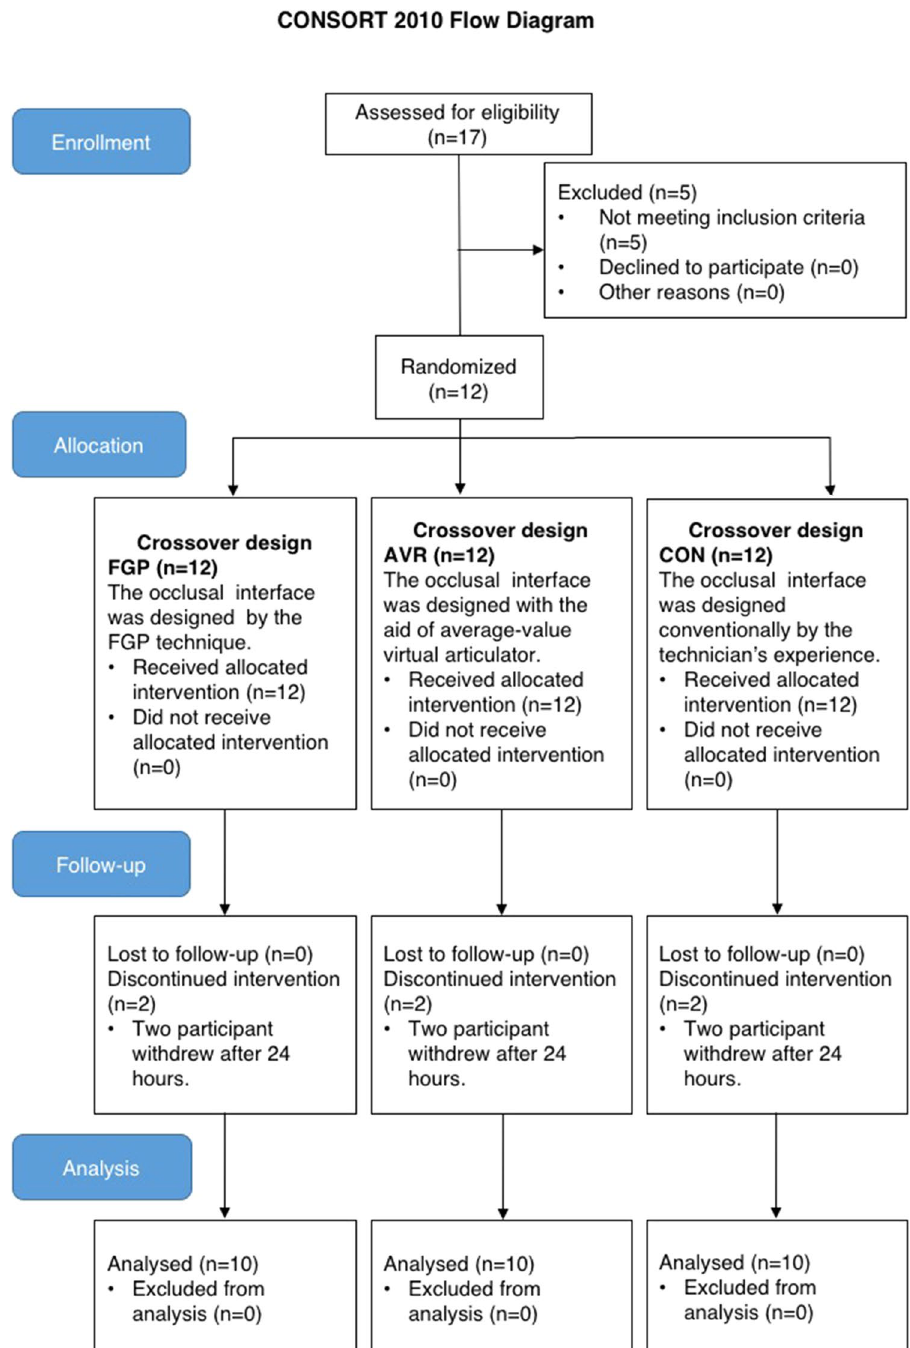
Figure 2. CONSORT flow diagram of subject randomization and selection